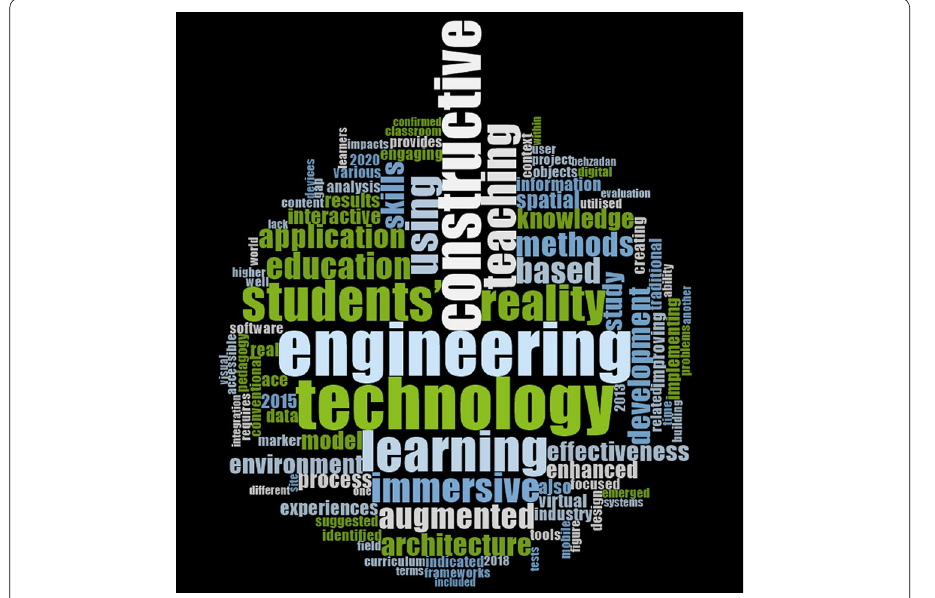
Fig. 9 Word frequency map of the topic